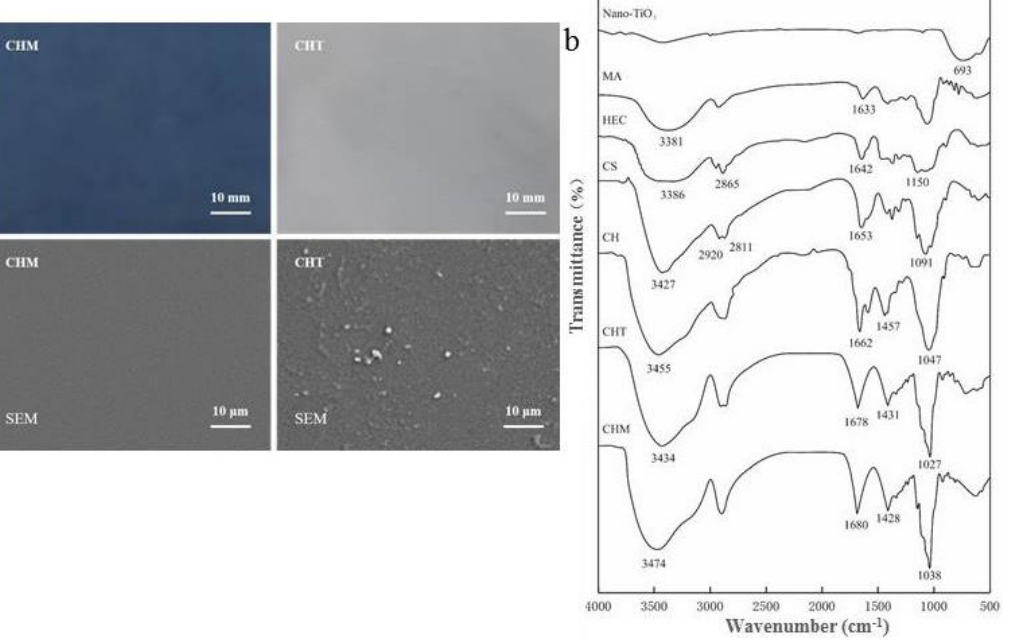
Figure 2. ( a ) The appearance and SEM images of the CHM and CHT materials, ( b ) Infrared spectra of each material.